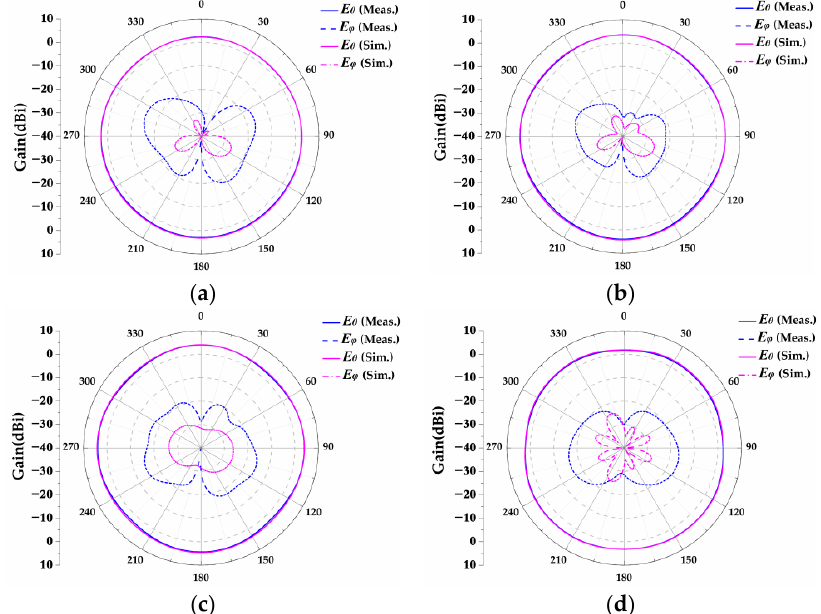
Figure 14. Simulated and measured un-roundness of radiation for State-II at xoy plane: ( a ) 1.6 GHz; ( b ) 1.8 GHz; ( c ) 2.0 G Hz; ( d ) 2.3 GHz.